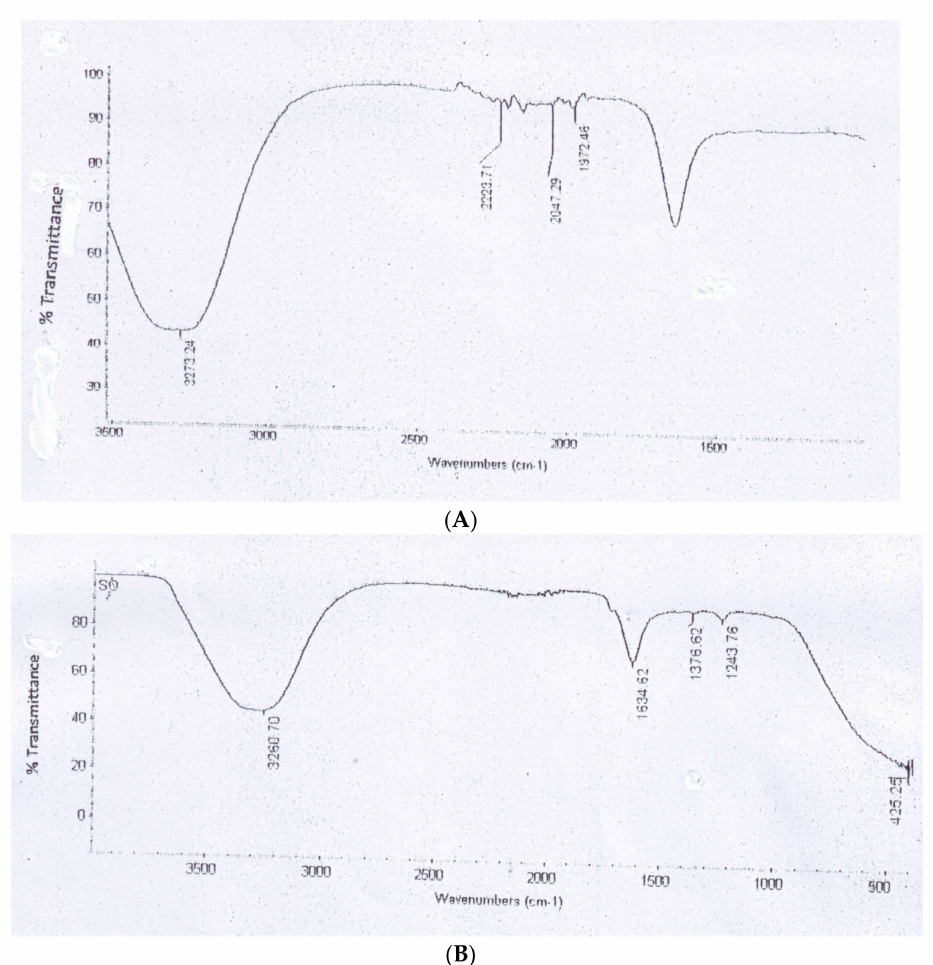
Figure 7. FTIR adsorption spectra of AgNPs prepared by pomegranate peel ( A ) and orange peel ( B ).